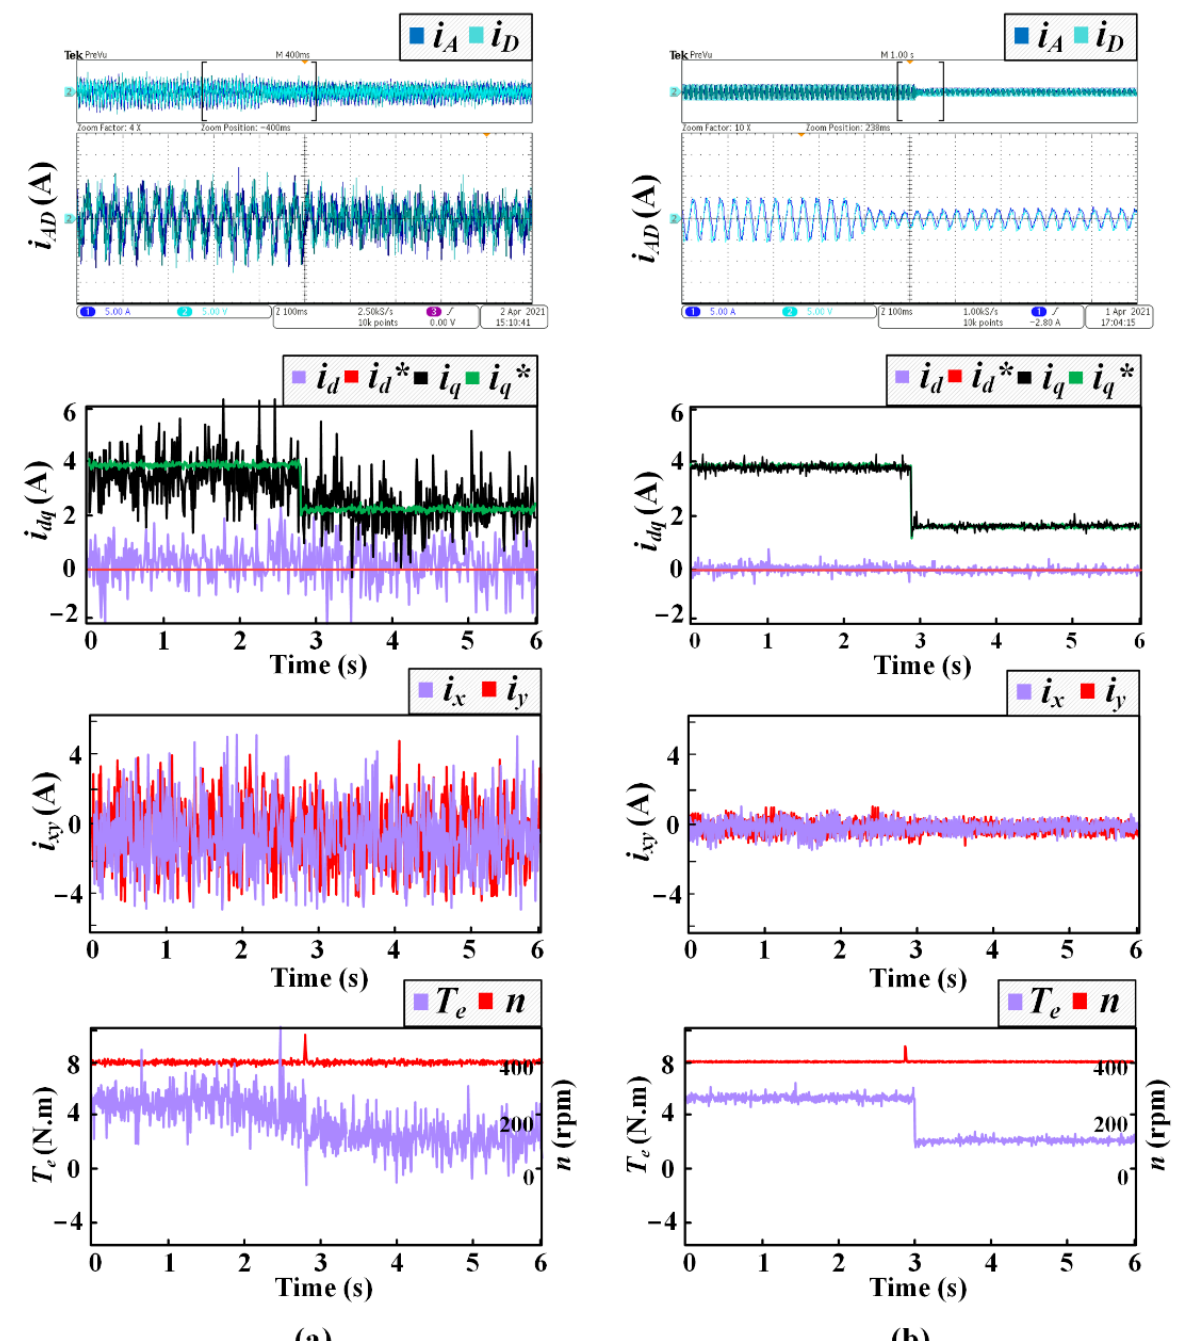
Figure 16. Test 3 for both methods with a sudden load decrease. ( a ) Conventional VV-MPC; ( b ) proposed MVV-MPC.